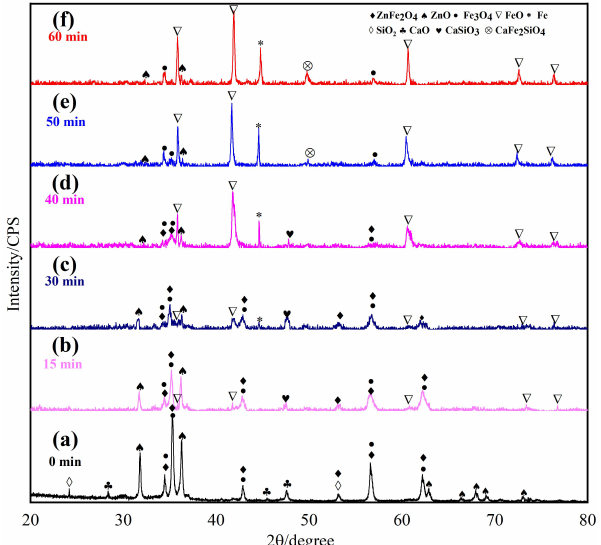
Figure 5. XRD patterns of the reduction products at different reduction times. ( a ) 0 min ( b ) 15 min ( c ) 30 min ( d ) 40 min ( e ) 50 min ( f ) 60